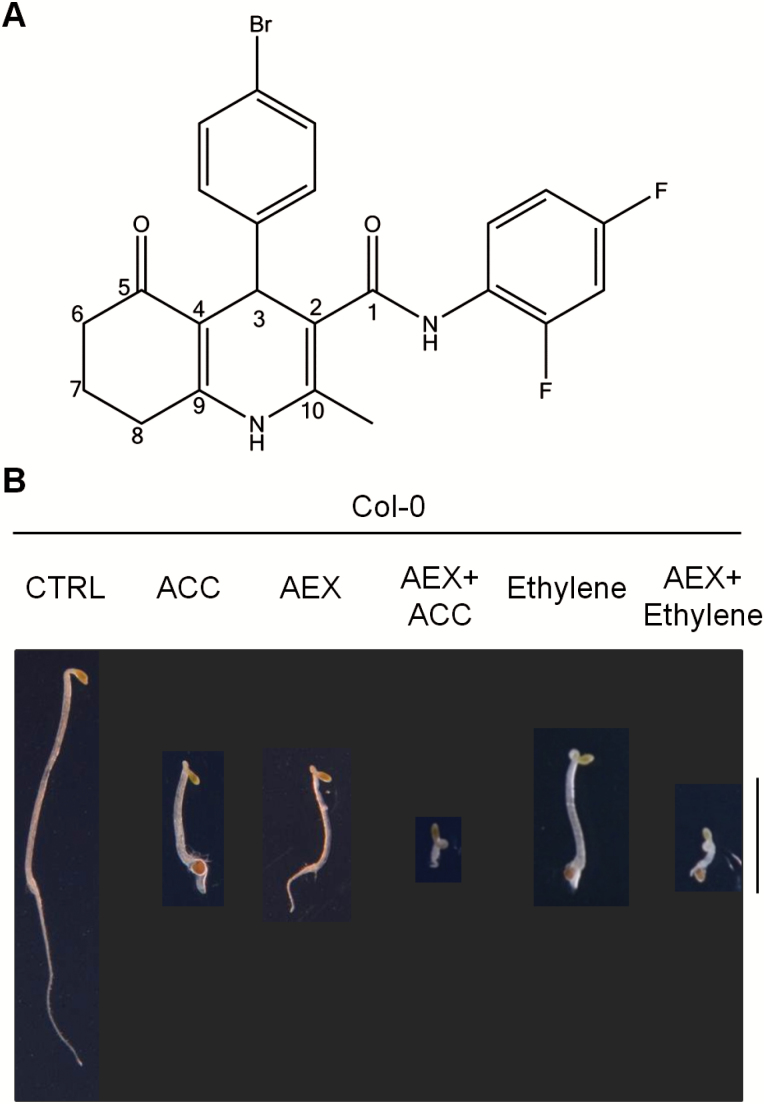
AEX enhances the triple response phenotype in Arabidopsis. (A) Chemical structure of AEX. IUPAC name: 4-(4-bromophenyl)-N-(2,4-difluorophenyl)-2-methyl-5-oxo-1,4,5,6,7,8-hexahydro-3-quinolinecarboxamide. Chembridge ID: 6527749. The carbon atoms of the quinoline carboxamide core are numbered. (B) Four-day etiolated seedlings of wild-type (Col-0) were grown on horizontal plates using half-strength MS medium containing 1% sucrose supplemented with 0.05% DMSO (CTRL), 10 µM ACC, 50 µM AEX, 10 µM ACC+50 µM AEX, or placed in air supplied with 5 ppm of ethylene or treated with the combination of 50 µM AEX+5 ppm ethylene. All treatments contained 0.05% DMSO. Individual photographs were cropped without changing the scale; the black background was post-added. Scale bar: 5 mm. (This figure is available in color at JXB online.)